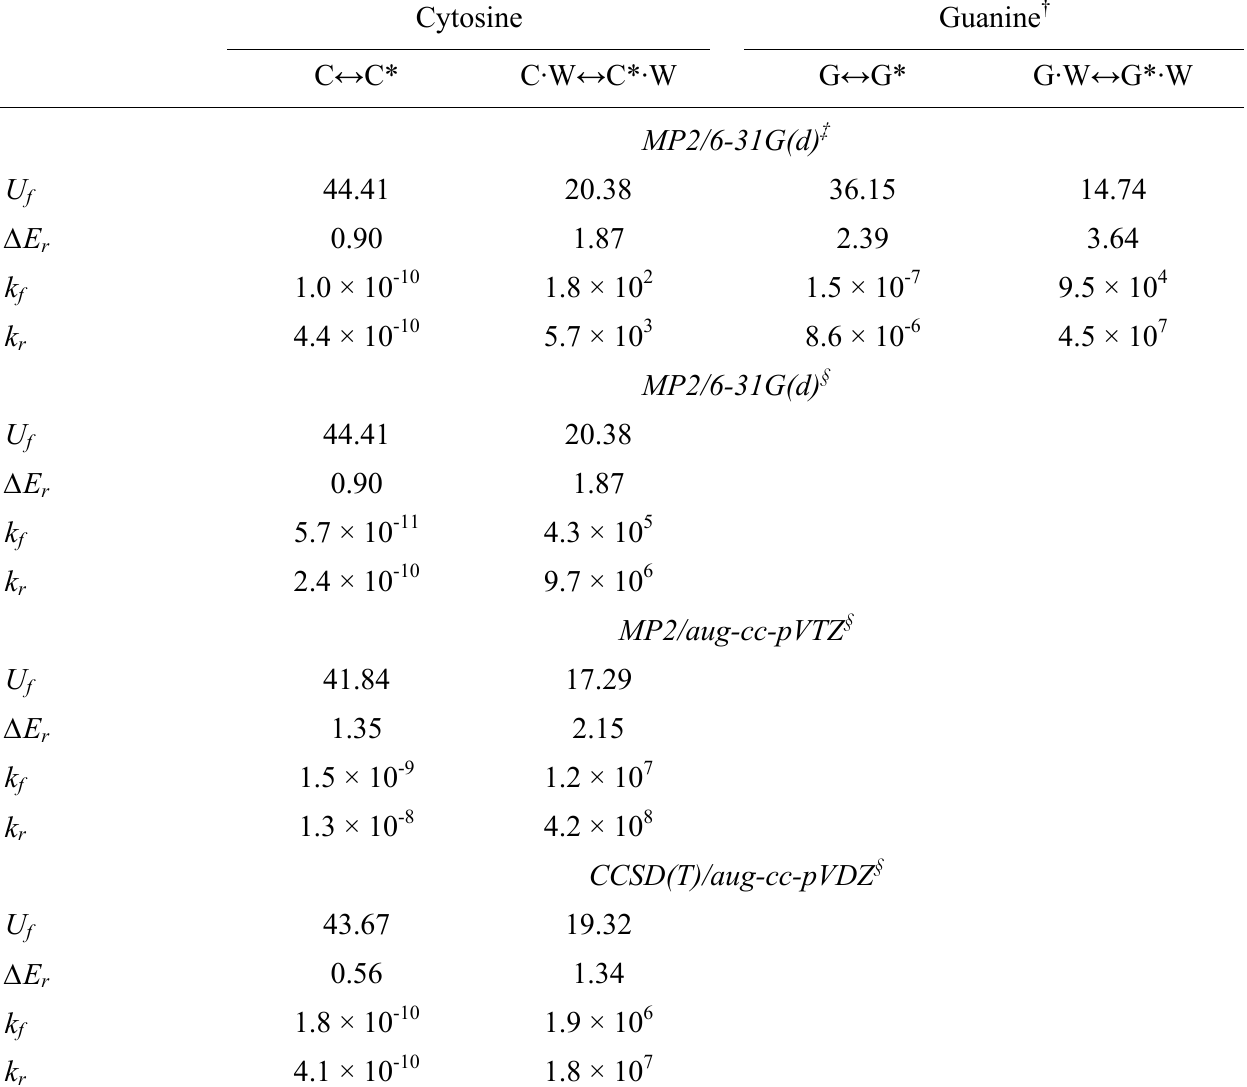
Table 2. Adiabatic Barrier Heights U (kcal mol -1 ), Exothermicities ∆ E (kcal mol -1 ), and Rate Constants k (s-1) for Forward (f) and Reverse (r) Directions of Cytosine and Guanine